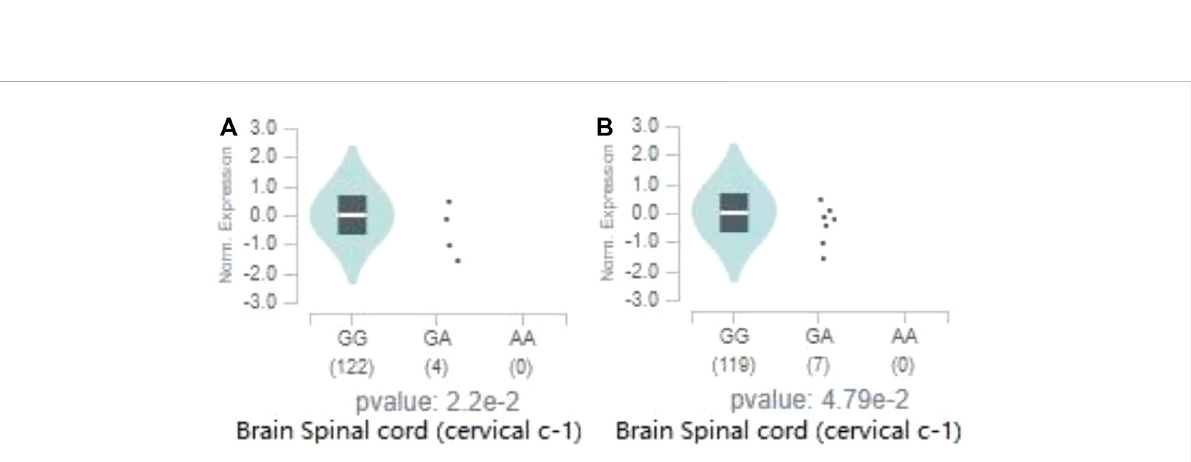
FIGURE 7 Effect of signi fi cant loci on the expression of EPHX2 . The above two fi gures reveal ‘ expression amount of EPHX2 on different genotypes of rs80263879 inspinal cord (cervical c-1) ’ (A) , ‘ expressionamount of EPHX2 on differentgenotypes of rs72478903 inspinal cord (cervical c-1) ’ (B) from Genotype-Tissue Expression (GTEx)